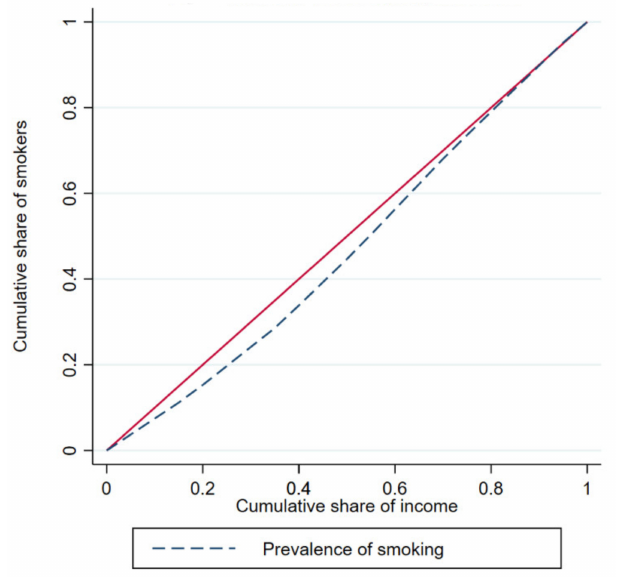
Figure 1. Income-based concentration curve.